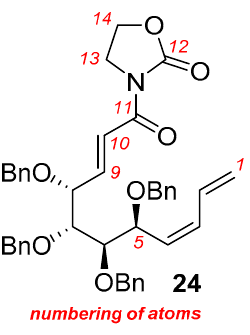
Figure 6. The structure of triene 24 and the numbering of the atoms.